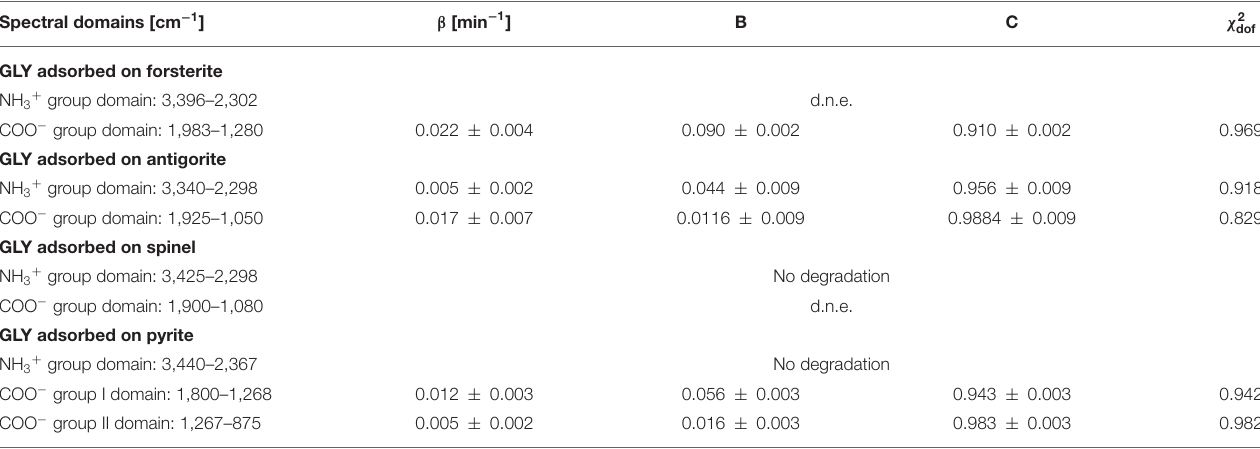
TABLE 7 | Best-fit values of the degradation rate β , the fraction of molecules that interact with UV radiation B, and the fraction of molecules that do not interact with UV radiation C , for spectral domains of GLY adsorbed on minerals UV irradiated in laboratory conditions. Spectral domains [cm − 1 ] β [min − 1 ] B C χ 2 dof